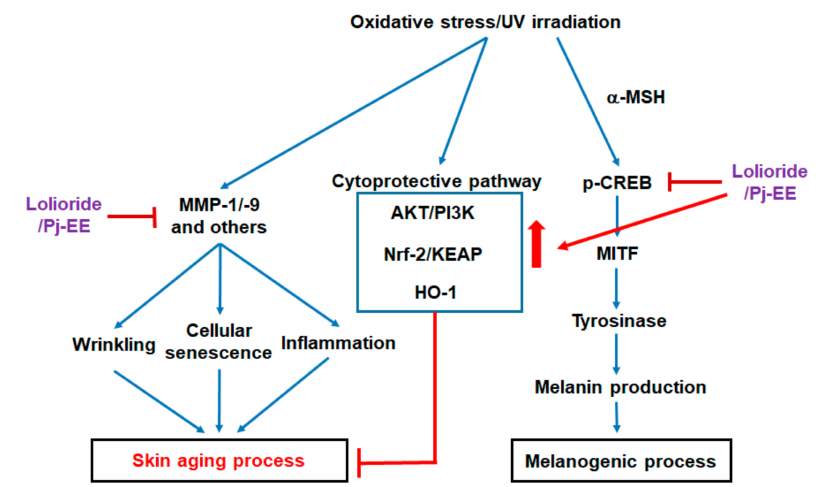
Figure 5. Mechanisms of oxidative stress-protective and anti-melanogenic effects of loliolide and Pj-EE. Red arrow: activation pathway induced by loliolide and Pj-EE, and blue arrow: positive pathway triggered by oxidative stress to activate downstream